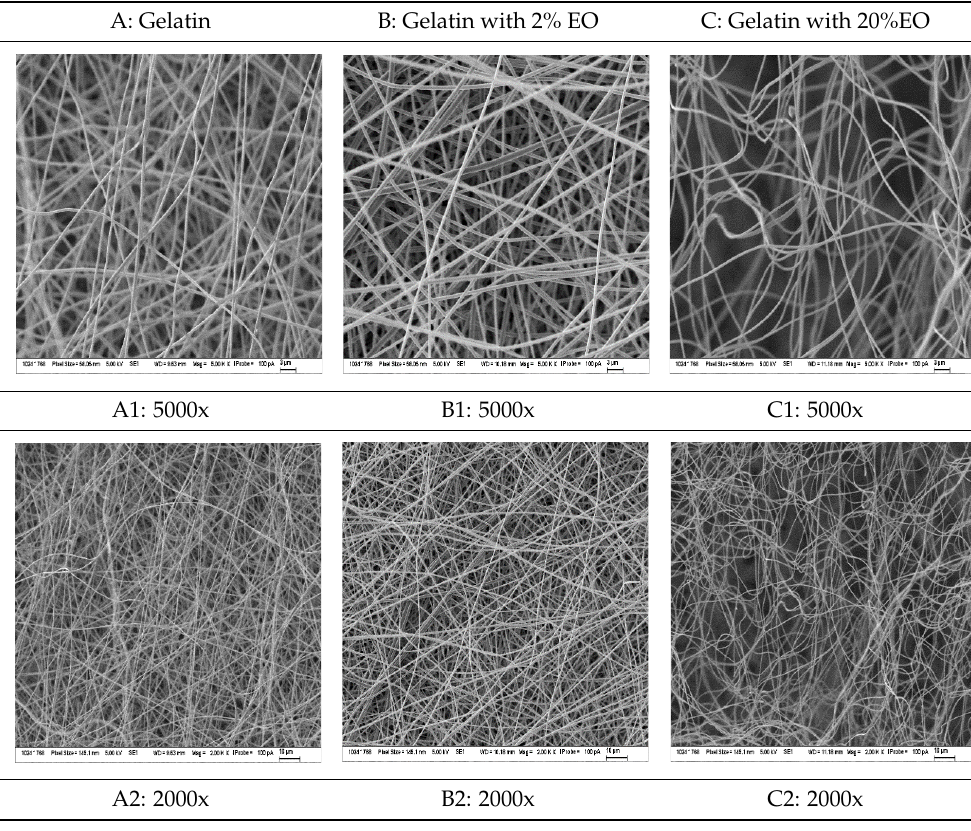
Table 8. SEM images of the morphology of electrospun gelatin fibers.